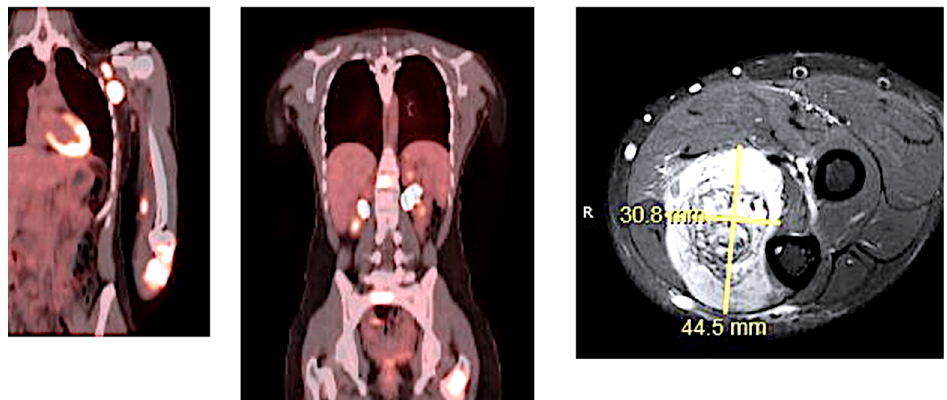
Figure 6. PET/CT and MRI of 19 y/o patient with Stage IV extremity alveolar RMS. Uptake can be appreciated in the left axillary node, left elbow and left femoral head.